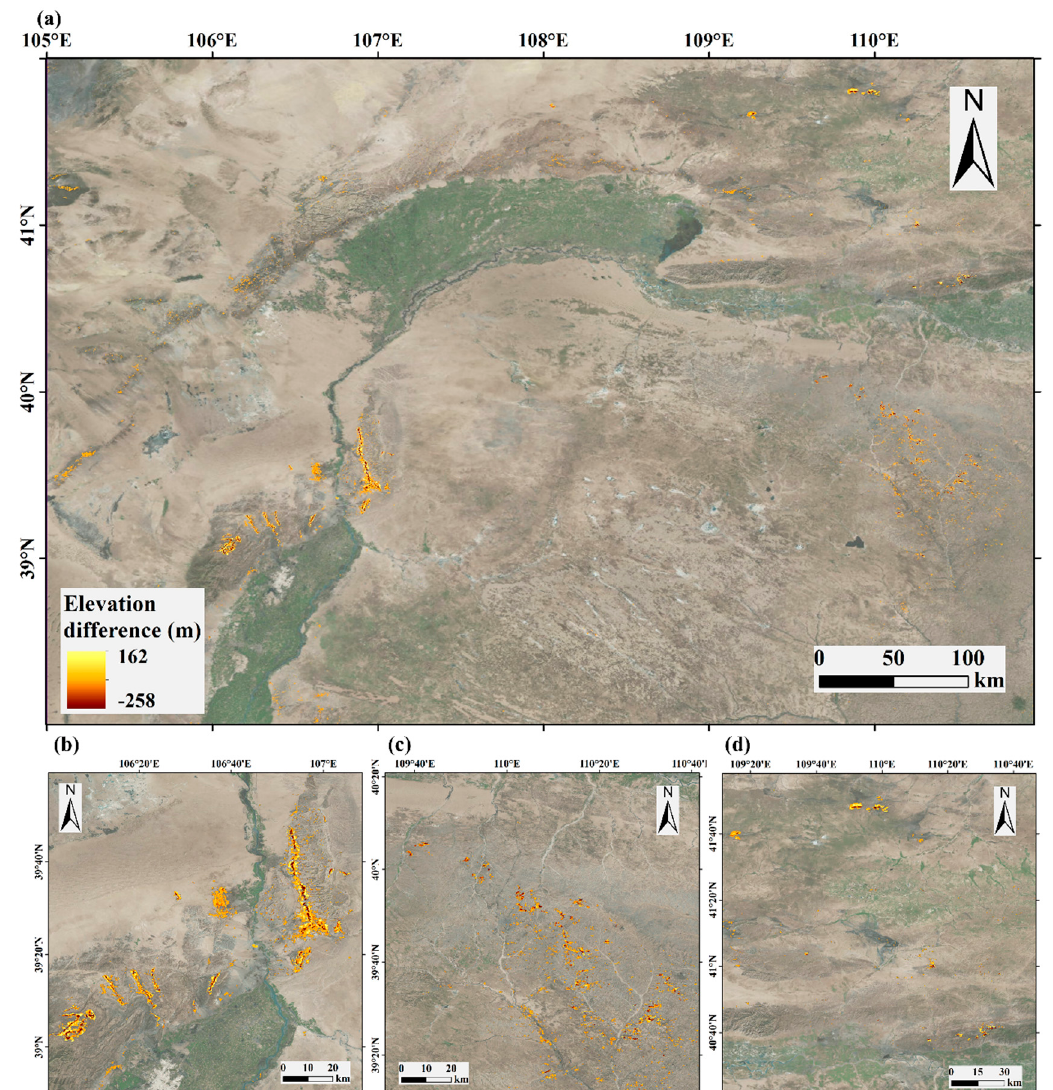
Figure 6. Elevation difference derived from the TanDEM-X and SRTM3. ( a ) the distribution of mining areas in the whole study area with elevation difference, ( b ) in the southwestern part, ( c ) in the southeast, and ( d ) in the northeast of the study area.